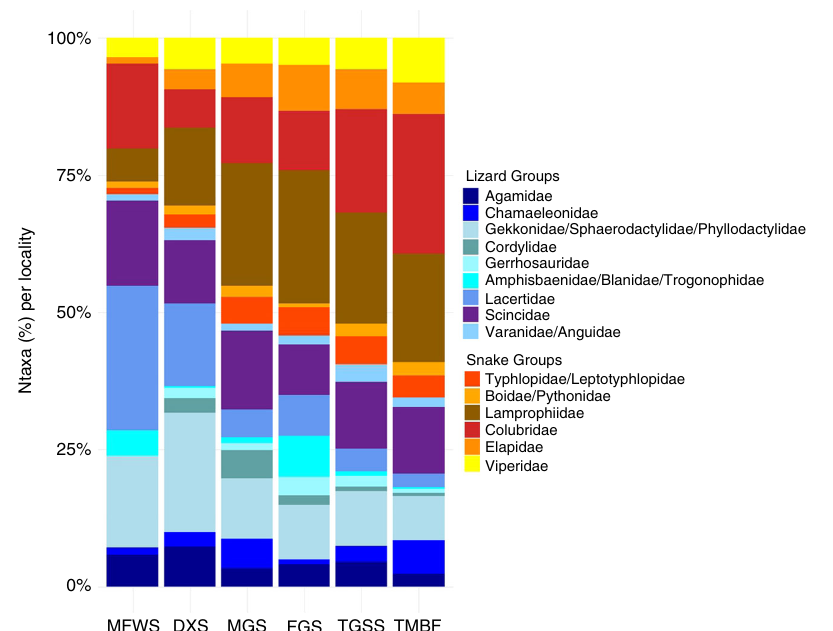
Fig. 5 Species richness of African squamates in different biomes. Relative number of taxa per locality of different squamate subgroups in different biomes. MFWS Mediterranean forests, woodlands and scrubs ( n = 2), DXS deserts and xeric shrublands ( n = 21), MGS montane grasslands and shrublands ( n = 7), FGS fl ooded grasslands and savannahs ( n = 1), TGSS tropical grasslands, savannahs and shrublands ( n = 30), TMBF tropical moist broadleaf forests ( n =